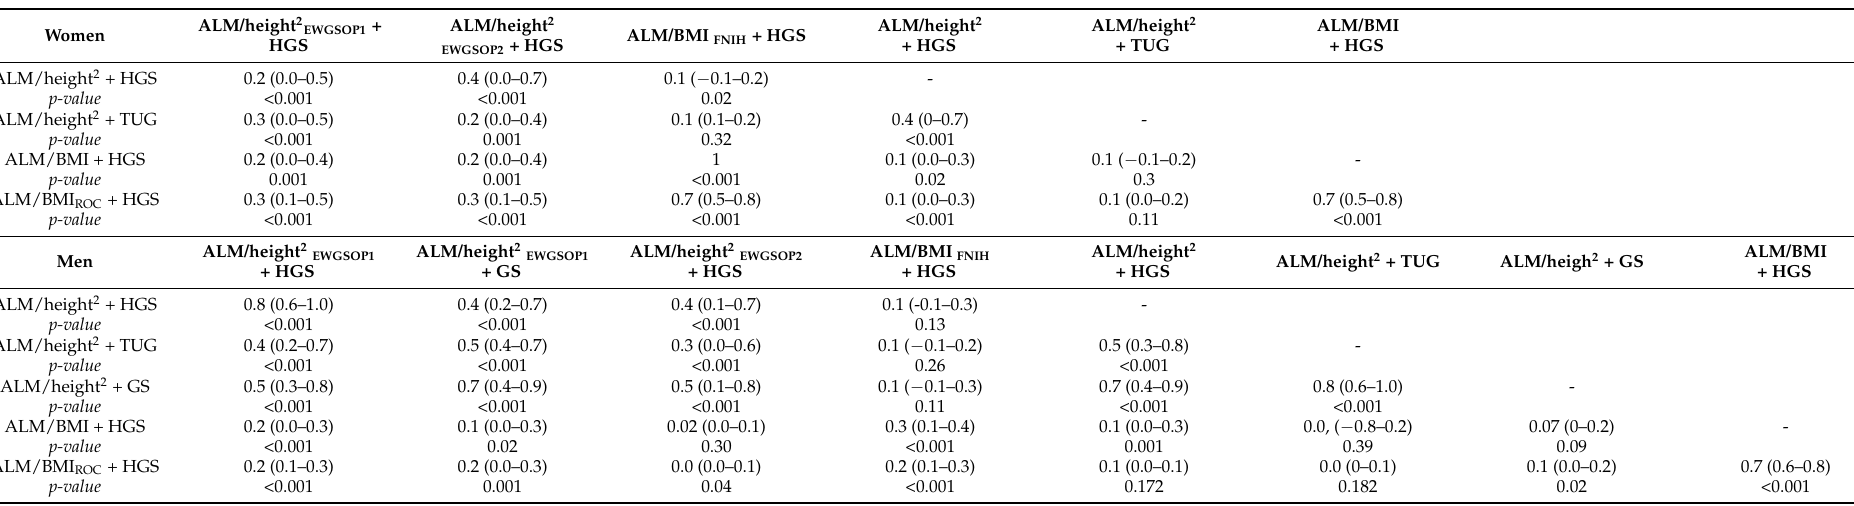
Table 4. Agreement between sarcopenia prevalence estimates according to different international and population-specific cut-points. Data are presented as κ , 95% confidence intervals and p